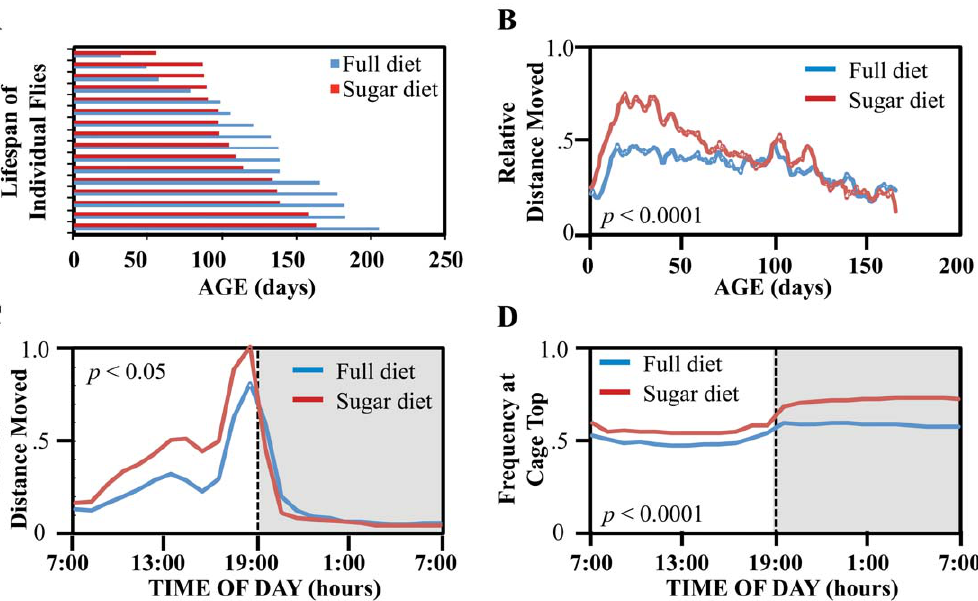
Figure 3. Age- and diet-specific behavior patterns of flies. ( A ) Lifspan of individual flies on full or sugar diet (red = full diet; blue = sugar-only diet; n=16 females for each diet). ( B ) Normalized average age- and diet-specific schedules of daily distance moved for A. ludens females. ( C ) Normalized average diet-specific frequency distribution of distance moved by A. ludens females through a 24-hour period. Grey area indicates the lights off period. ( D ) Average diet-specific frequency of time spent at the top of the cage for A. ludens females through a 24-hour period. The p values indicating the difference in diet-specific changes are shown in each panel.